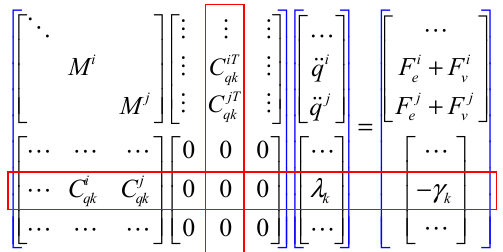
Figure 6. Method to remove constraints from the dynamic equations.